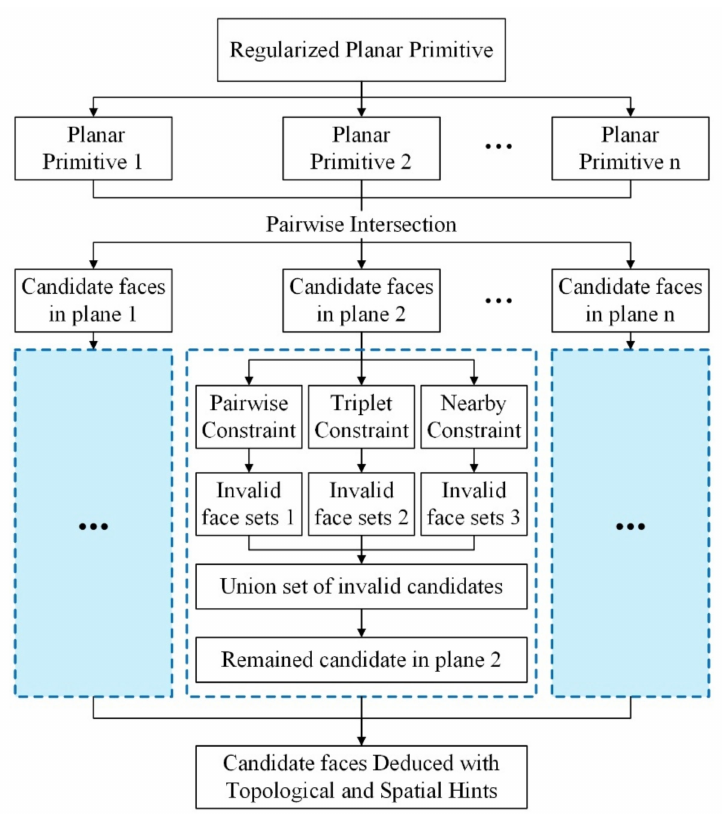
Figure 4. Overall workflow of the proposed candidate face deduction